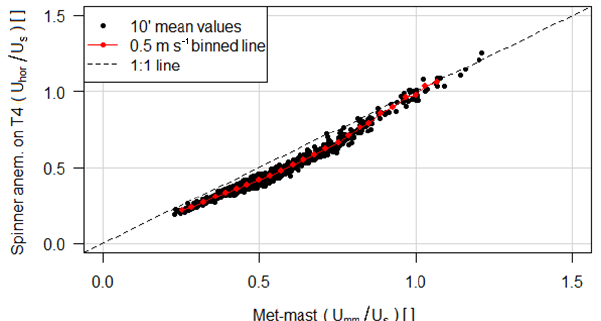
Figure 6. Nacelle transfer function measured with the spinner anemometer of wind turbine 4. Red line is the NTF obtained by linear interpolation between the red dots, which are the NTF binned